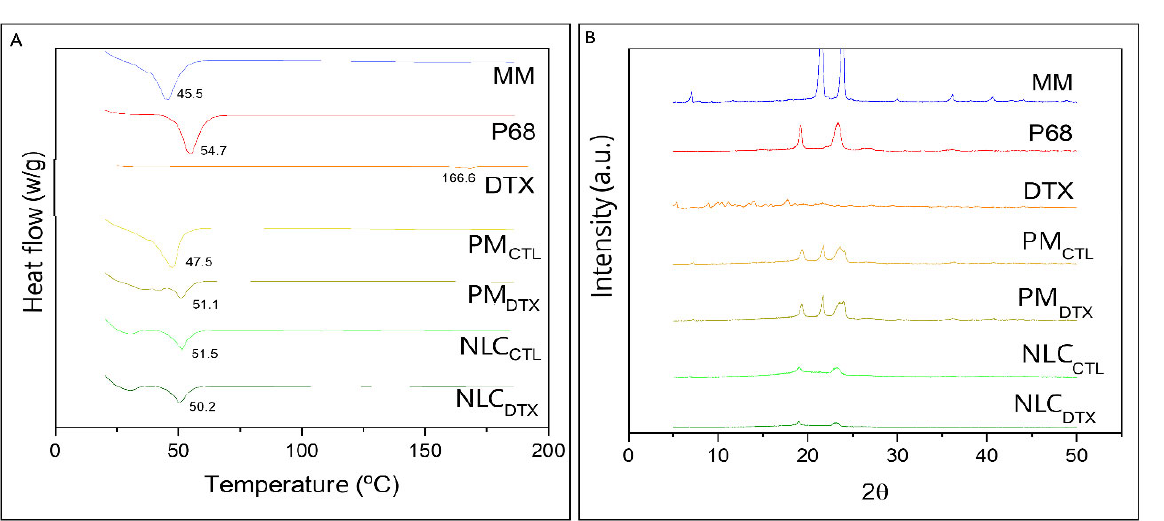
Figure 4. ( A ) DSC thermograms of pure myristyl myristate (MM), Pluronic F-68 (P68), Docetaxel (DTX), physical mixture of excipients without DTX (PM CTL ), with DTX (PM DTX ), NLC without (NLC CTL ) and with DTX (NLC DTX ) determined at a heating rate of 10 ◦ C min − 1 ; ( B ) X-ray diffractograms of: MM, P68, DTX, PM CTL , PM DTX , NLC CTL and NLC DTX obtained using a Cu ‐ K α source, at 2° min − 1 .